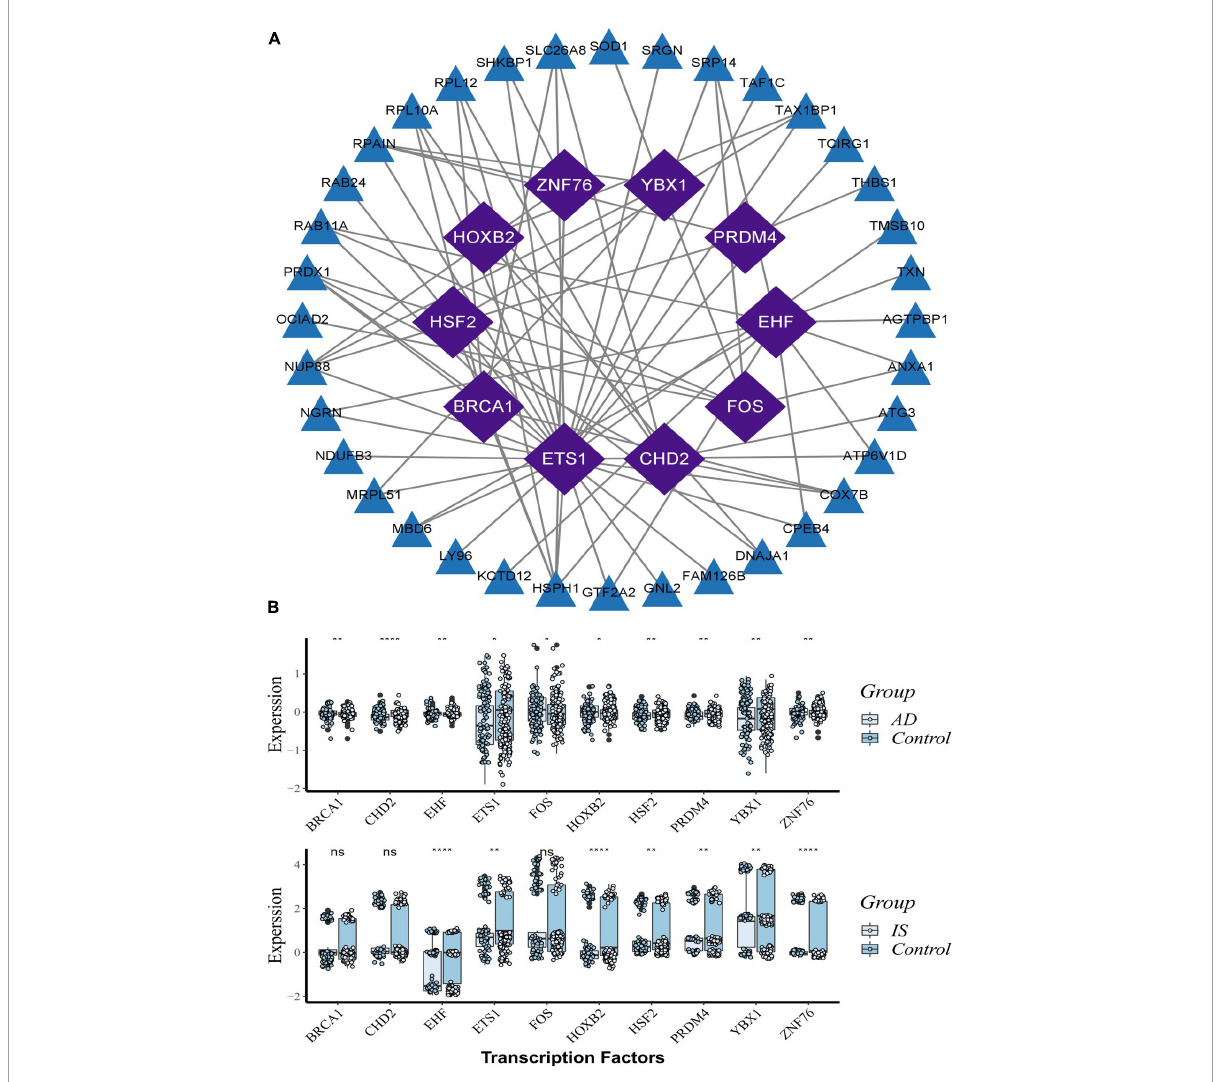
FIGURE6 Transcription factors (TFs) regulatory network and their gene expression profiles in AD/IS. (A) TFs regulatory network. TFs were marked in purple, and the hub genes were marked in blue. (B) The gene expression level of TFs in AD and IS datasets. The comparison of gene expression between patients and controls was applied with t -test. P -value < 0.05 was considered statistically significant. AD, Alzheimer’s disease; IS, ischemic stroke. * P < 0.05; ** P < 0.01; **** P <